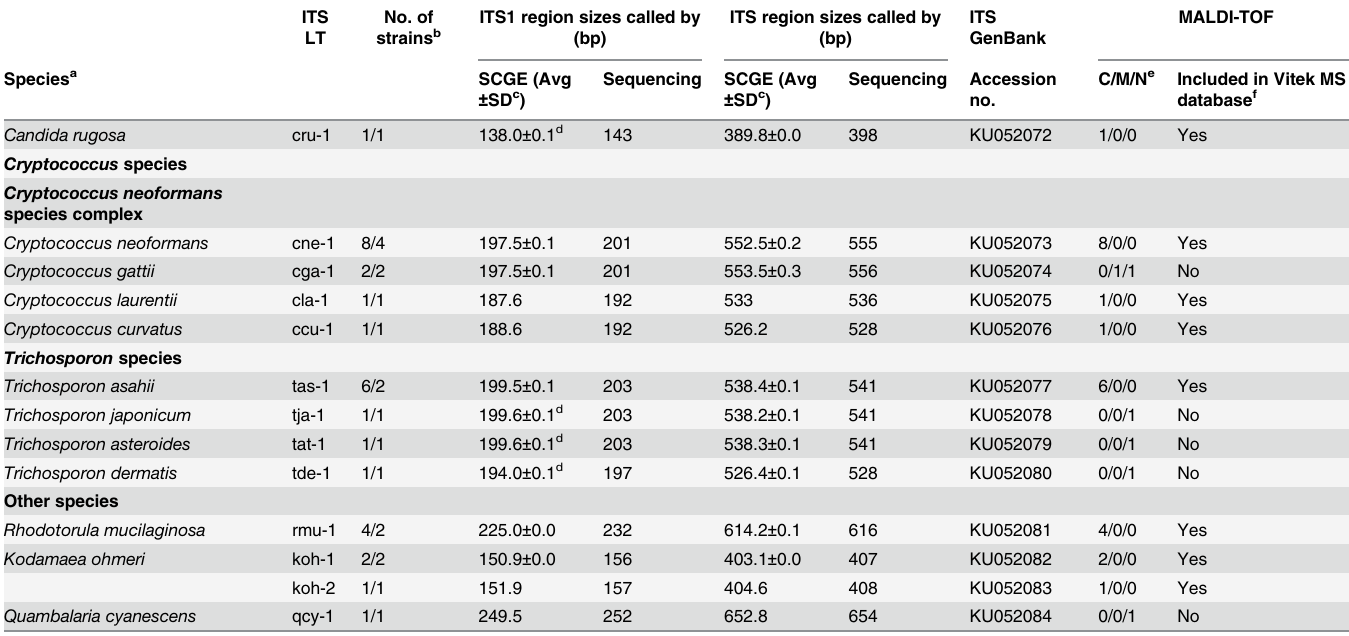
isolates were identified by MALDI-TOF MS (Vitek MS, bioMérieux, Marcy l ’ Etoile, France, database version IVD 2.0) according to the manufacturer ’ s instructions. Any isolates with